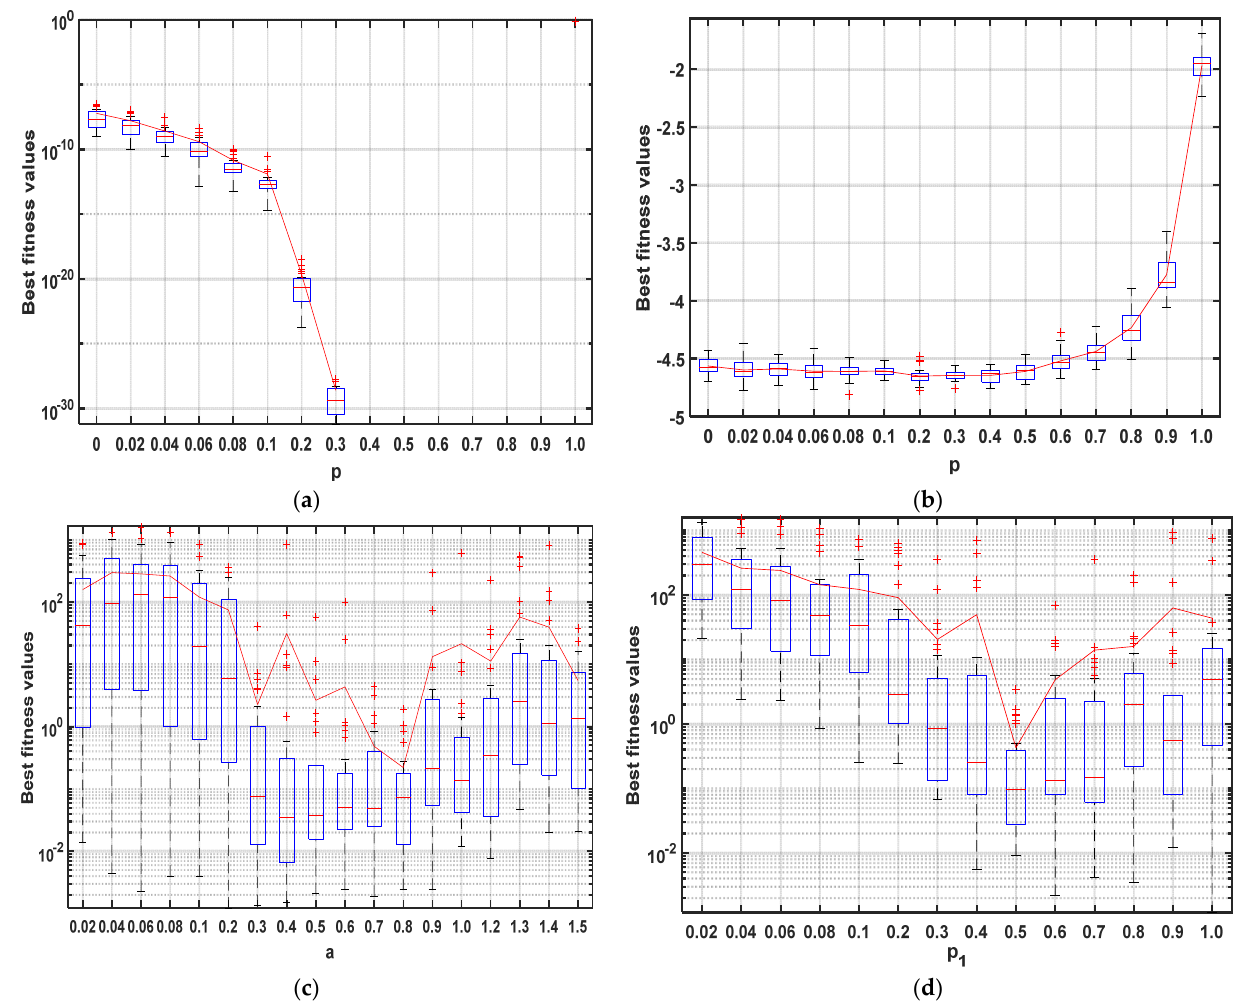
Figure 4. Sensitivity analysis for the parameters of the proposed algorithms: ( a ) Depiction of outcomes under various values for parameter p on F1; ( b ) Depiction of outcomes under various values for parameter p on F5; ( c ) Depiction of outcomes under various values for parameters a on F14; ( d ) Depiction of outcomes under various values for parameters p ₁ on F14.